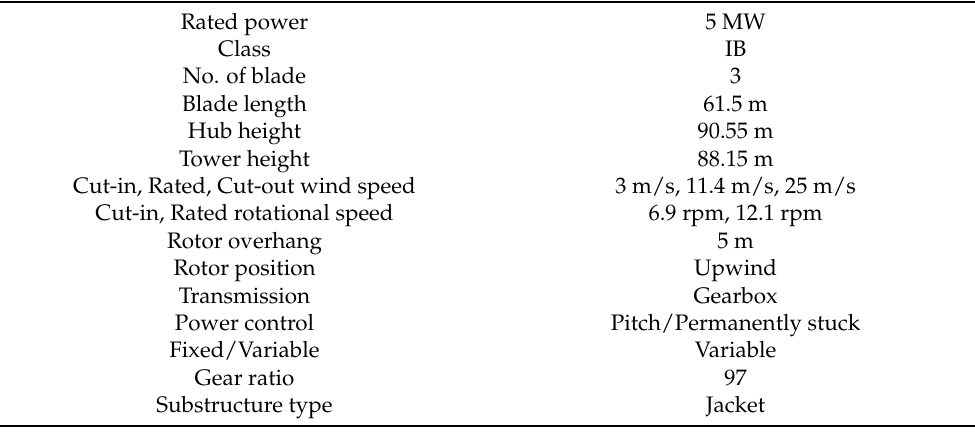
Figure 1. Schematic of jacket type substructure. Table 1. General specification.